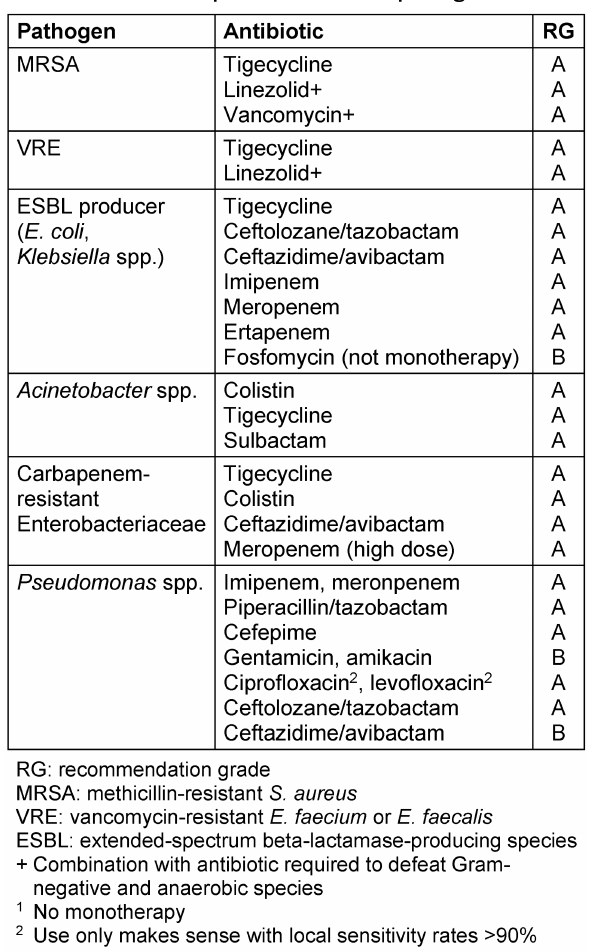
Table 2: Calculated antibiotic treatment for intra-abdominal infection suspected of resistant